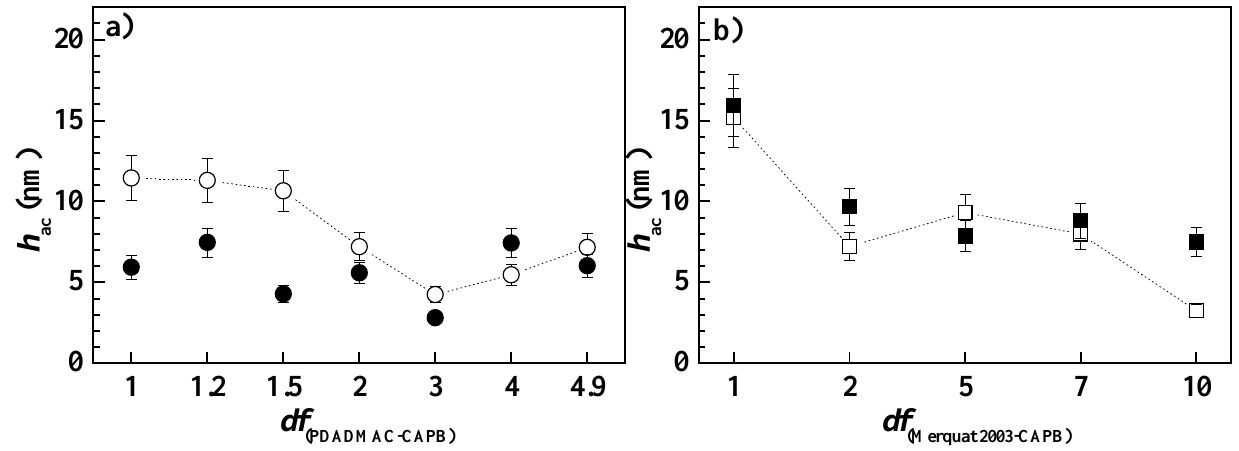
Figure 6. Acoustic thickness before (o and □) and after (● and ■ ) rinsing/dilution for the adsorption of pseudo-binary polymer–CAPB mixtures obtained upon dilution at different values of df of a pseudo-binary polymer–surfactant mixture with the same concentration of the components as those presented in the formulation of Table 2. ( a ) Mixtures with PDADMAC. ( b ) Mixtures with Merquat